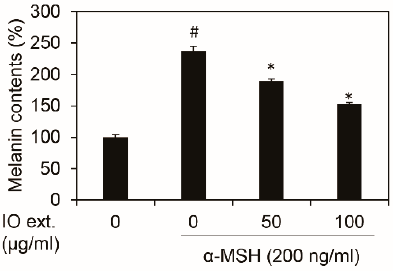
Figure 2. Effects of the Inonotus obliquus extract on the melanin contents in the B16F10 mouse melanoma cells. The Inonotus obliquus extract decreased the melanin contents in the B16F10 mouse melanoma cells. The number of cells was counted, and the amount of melanin in the cells was measured. The melanin contents were shown as a percentage of the control at the stated concentrations. The data values were obtained from the average of three independent experiments ± SD (standard deviation). #: p < 0.05 compared to the non-treated B16F10 cells; *: p < 0.05 compared with the α -MSH-treated B16F10 cells; IO ext.: Inonotus obliquus extracts; and α -MSH: alpha-melanocyte-stimulating